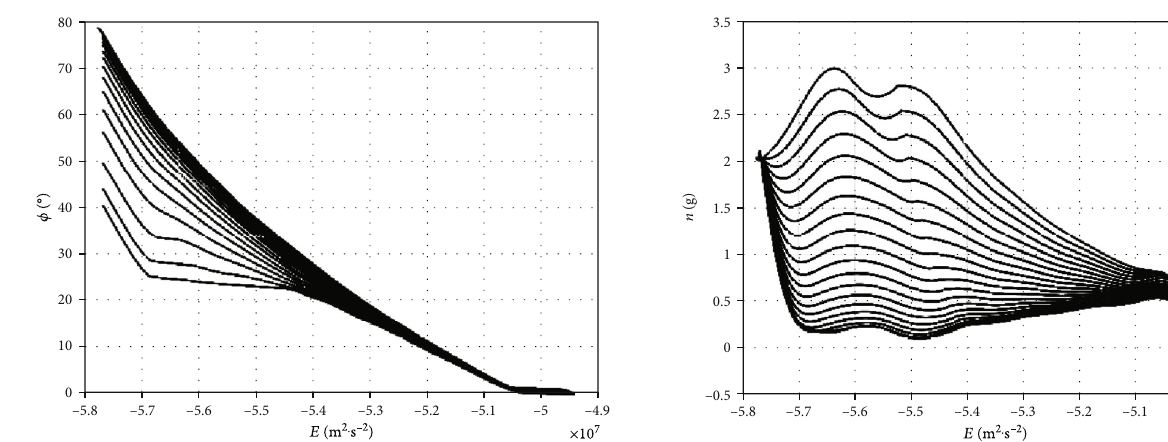
Figure 26: Normal acceleration pro fi les for Case 1.